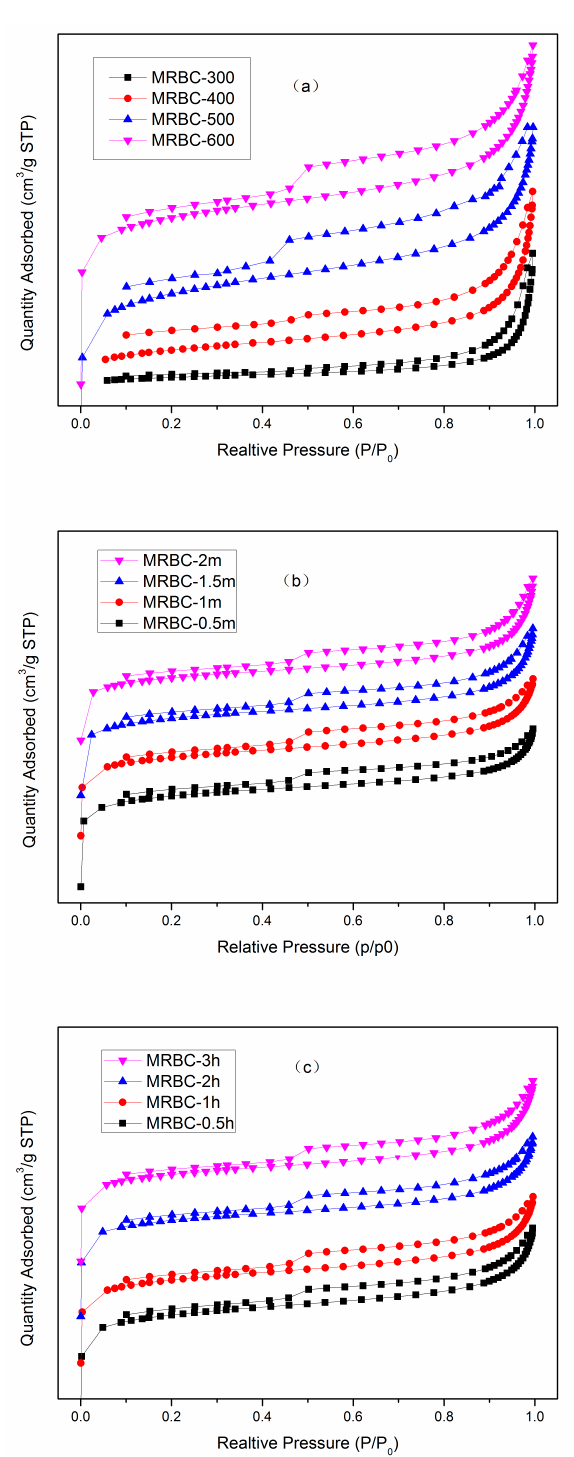
Figure 1. The nitrogen adsorption/desorption curves of biochar prepared at different conditions: ( a ) pyrolysis temperature; ( b ) MgCl 2 impregnation concentration; ( c ) pyrolysis time.